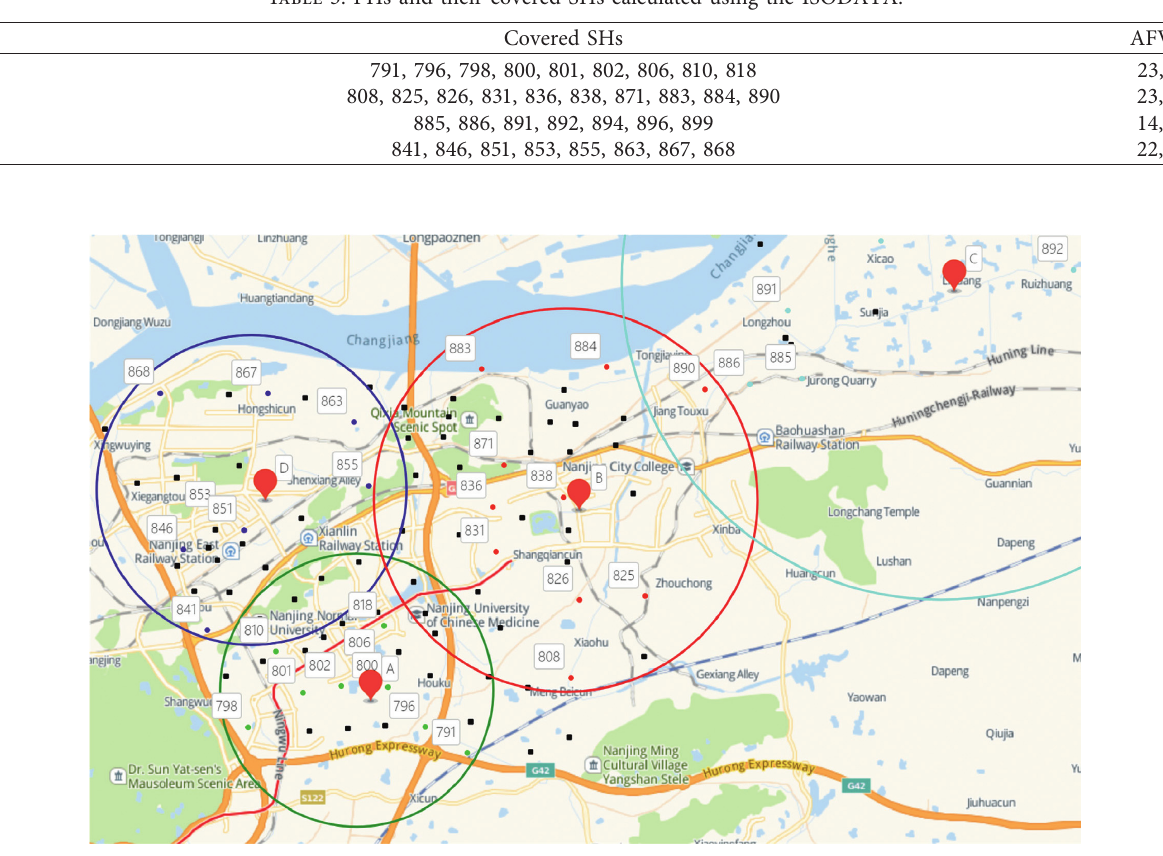
Table 3: PHs and their covered SHs calculated using the ISODATA.